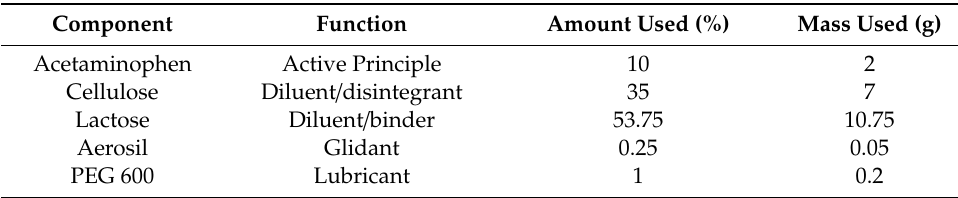
Table 1. Constituents of blend for